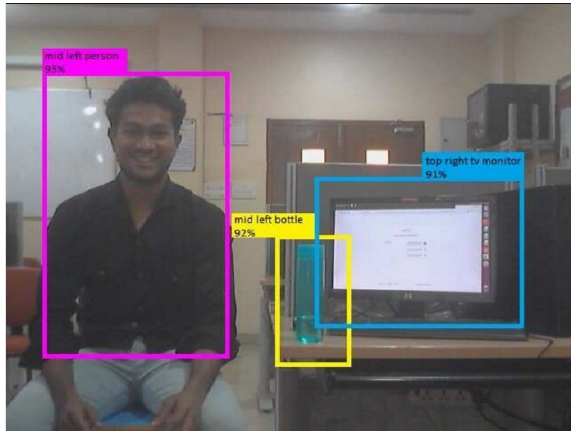
Figure 4. The output of YOLO algorithm for Frame-1.